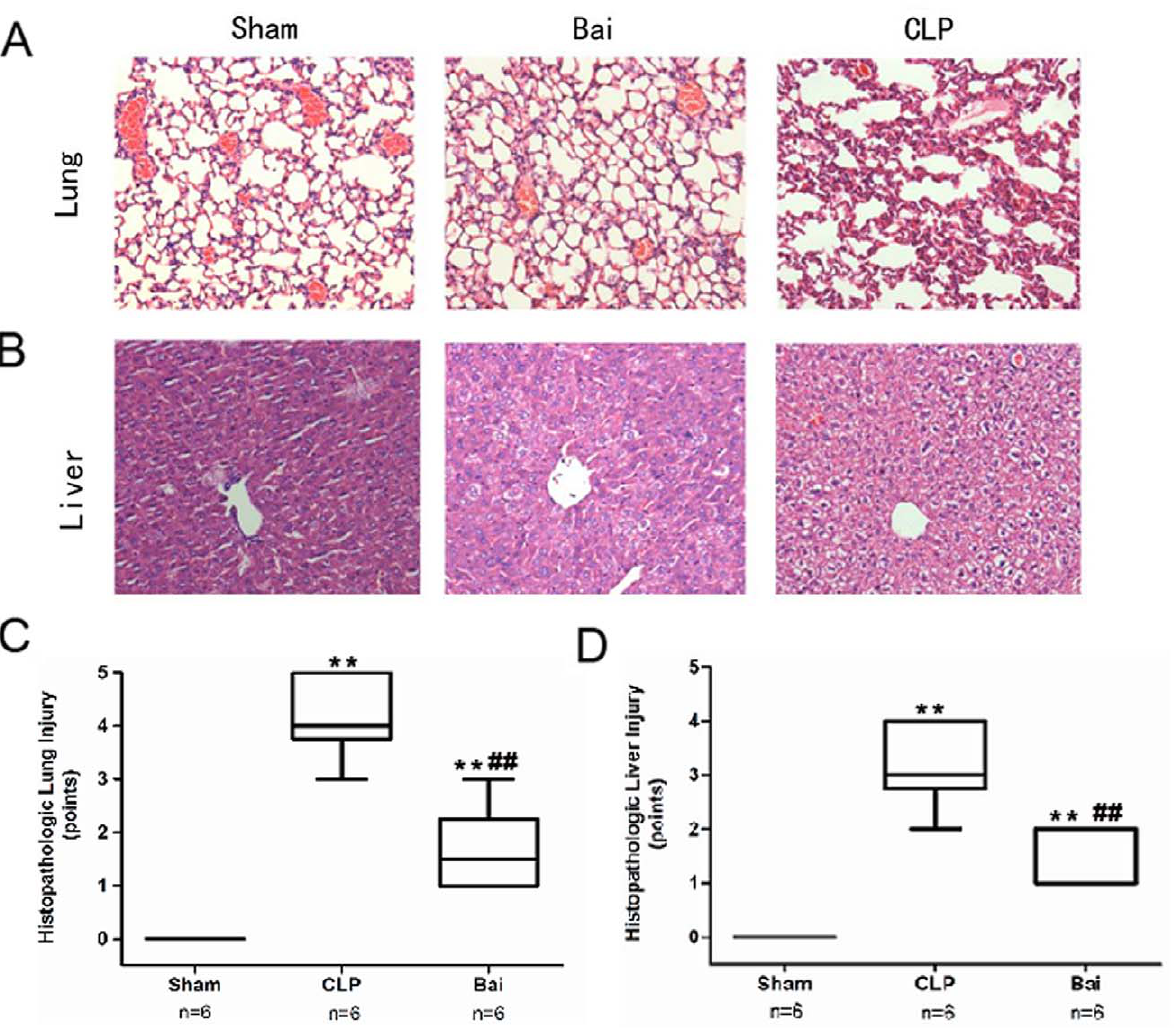
Figure 4. Histopathological changs of septic mice after baicalin treatment. The tissues were harvested 24 h after CLP for histopathologic examination using hematoxylin and eosin staining. Representative images from six animals per group were shown. Histopathological tests showed milder impairment in lung and liver after baicalin administration. A, After baicalin treatment, lung showed less neutrophil accumulation and alveolar destruction. B, Hepatocytes were protected and hepatic sinusoid was also preserved in baicalin treated mice. C, the severity of lung injury was scored as described in Materials and methods. D, the severity of liver injury was scored as above. ** P , 0.01 vs. sham. ## P , 0.01 vs. CLP. Bai, baicalin group; CLP, CLP